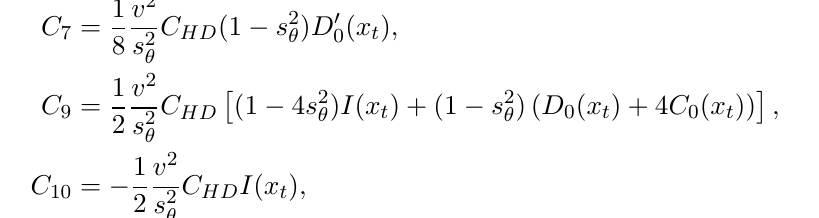
Figure 9 . Diagrams generating contributions to b ! sl + l (cid:0) from the operator Q (3) diagrams should be taken to include also similar diagrams with the e(cid:11)ective operator attaching to the l + line rather than the l (cid:0) line, while the fourth diagram should be taken to include all other Z penguin diagrams (including those with self-energies on external legs) where these operators a(cid:11)ect the Zl + l (cid:0)